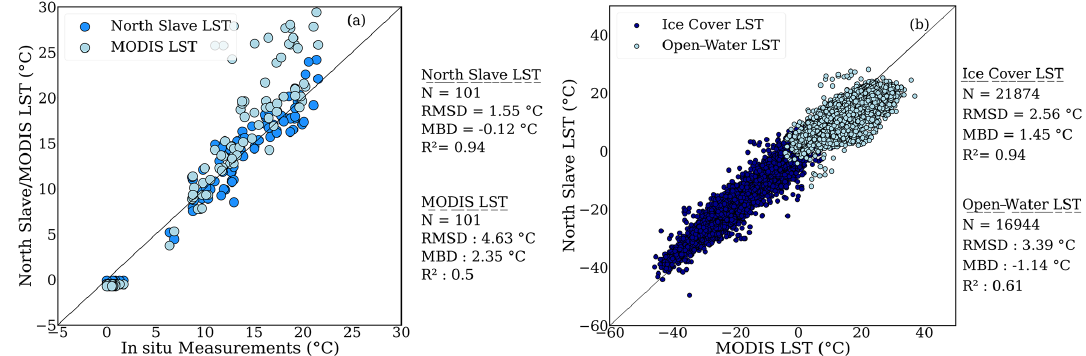
Figure 6. Comparison of North Slave LST and MODIS LST to (a) DataStream and ECCC in situ water surface temperature measurements during open-water seasons (b) MODIS LST during open-water and ice-covered seasons.